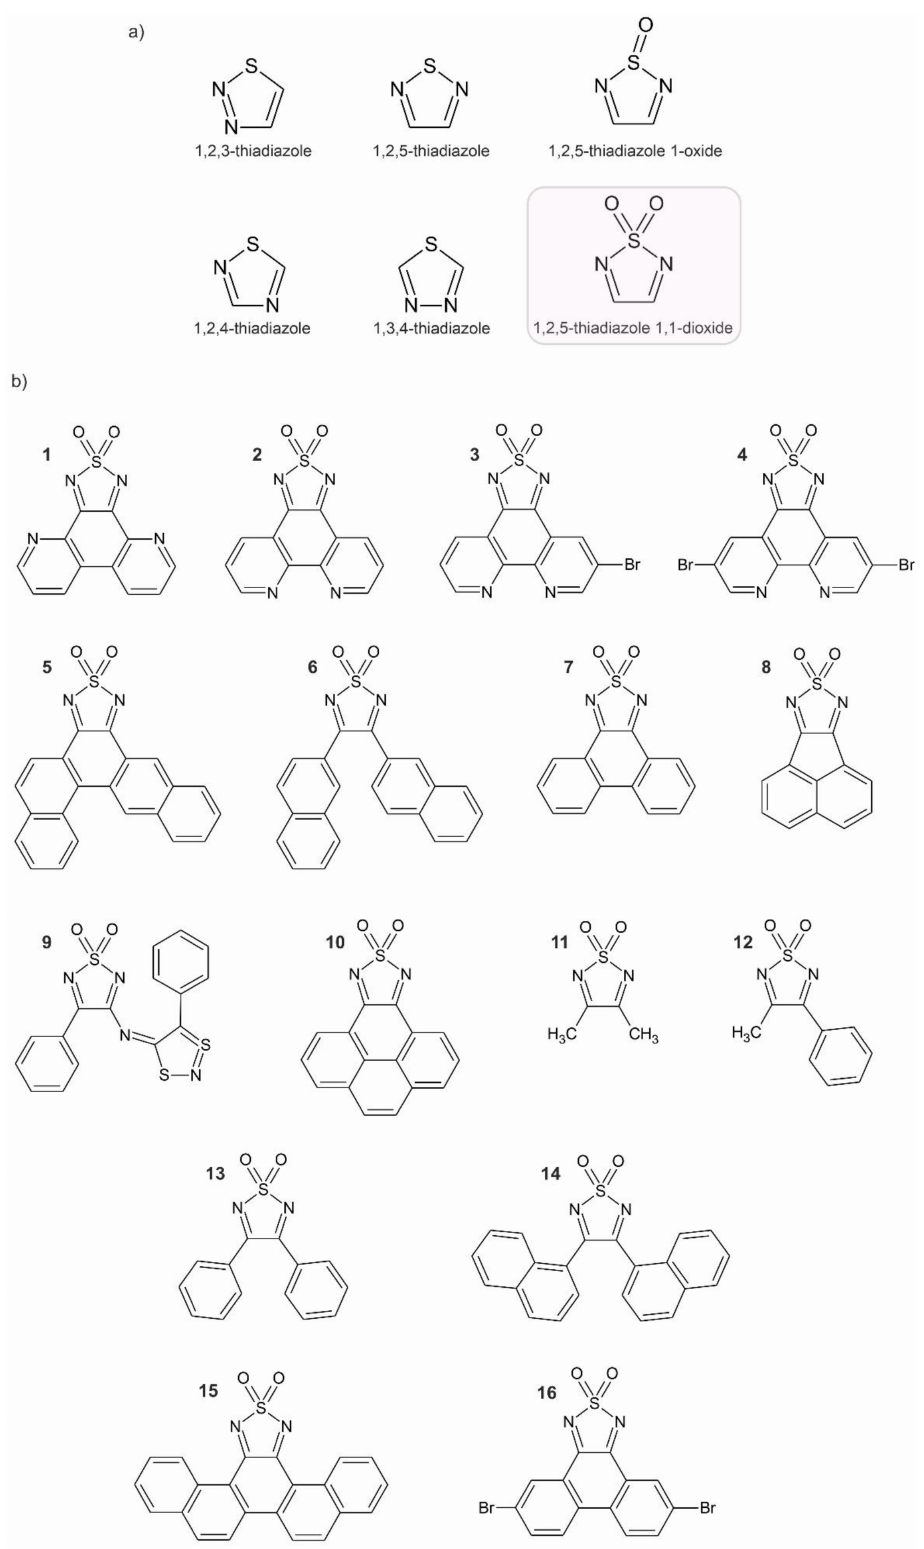
Figure 1. The family of the thiadiazole heterocycles including 1,2,5-thiadiazole 1,1-dioxides ( a ) and the structural formulas of all 1,2,5-thiadiazole 1,1-dioxides characterized structurally by means of SCXRD according to the Cambridge Structural Database search: 10 June 2021 ( b ). See Table 1 for additional details and literature